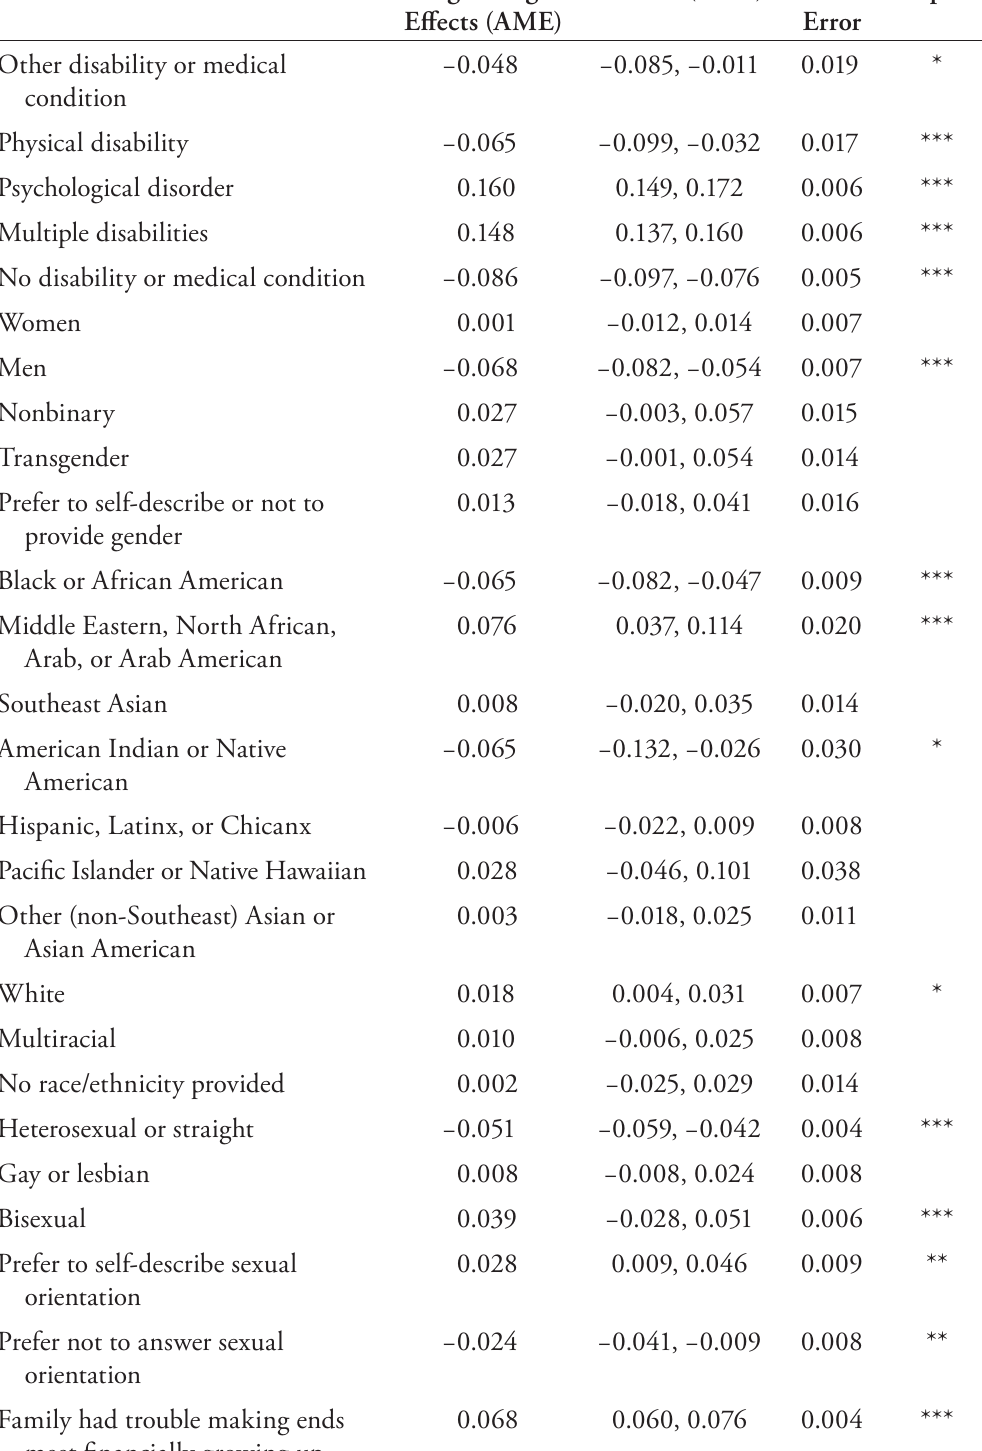
Table 3. Results of the Logistic Regression for Generalized Anxiety Disorder (GAD) ( continued